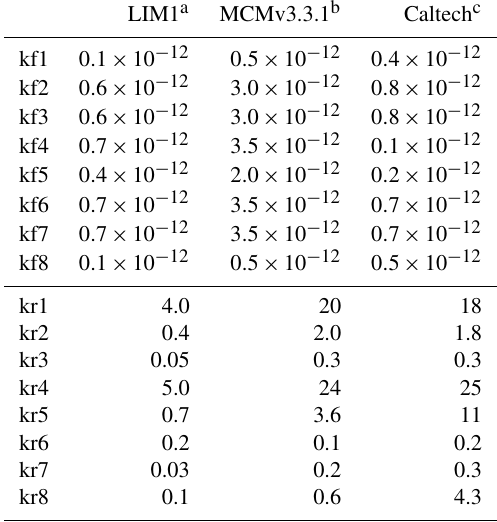
Table 1. The rate coefficients for the addition of O 2 to OH-isoprene adducts and for the re-dissociation of isoprene-RO 2 (Fig. 1). The rate coefficients for the oxygen additions (kf; cm 3 s − 1 ) are typically temperature-independent or provided at 298.15K. The rate coeffi- cients for the re-dissociations (kr; s − 1 ) are provided at 298.15K. The temperature-dependent rate coefficients are given in Table